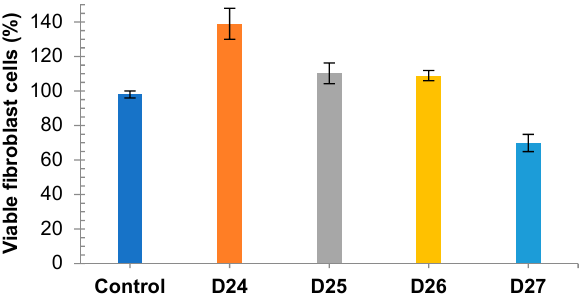
Figure 3. In vitro human fibroblast AW/4 cell viability (trypan blue staining) in the presence of dendrimers D24–D27 at 20 µ M concentration shown as % of the control with E.S.Ds. (cells incubated only with culture media, 98%).